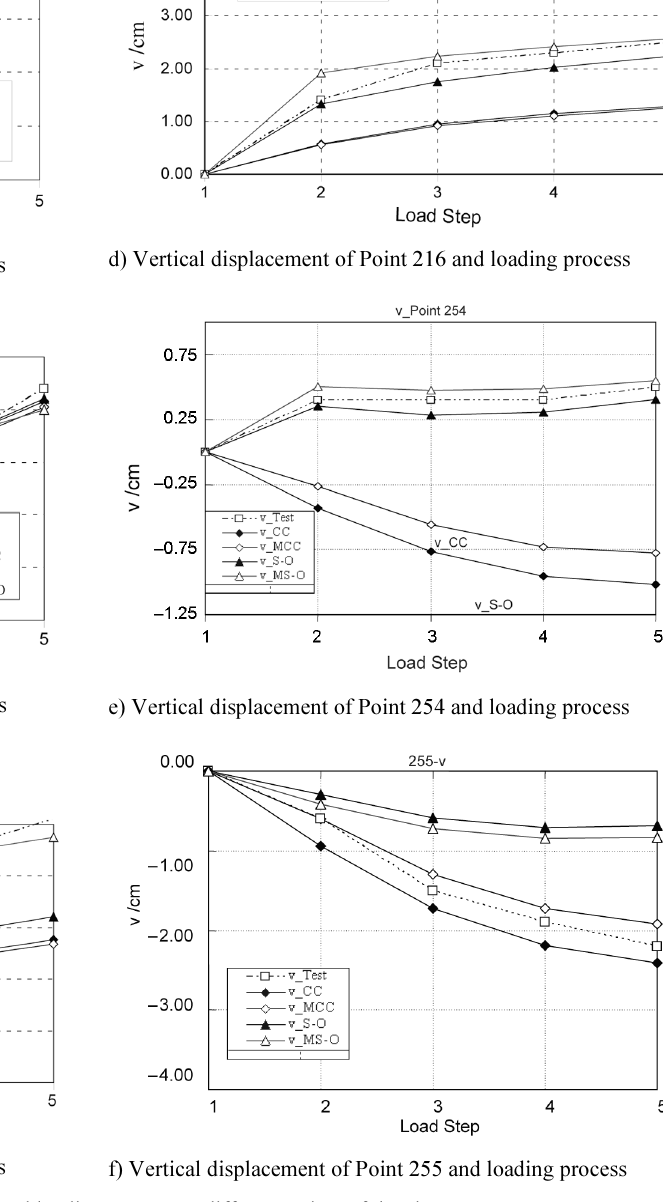
Fig. 7. Vertical displacements and loading process at different points of the